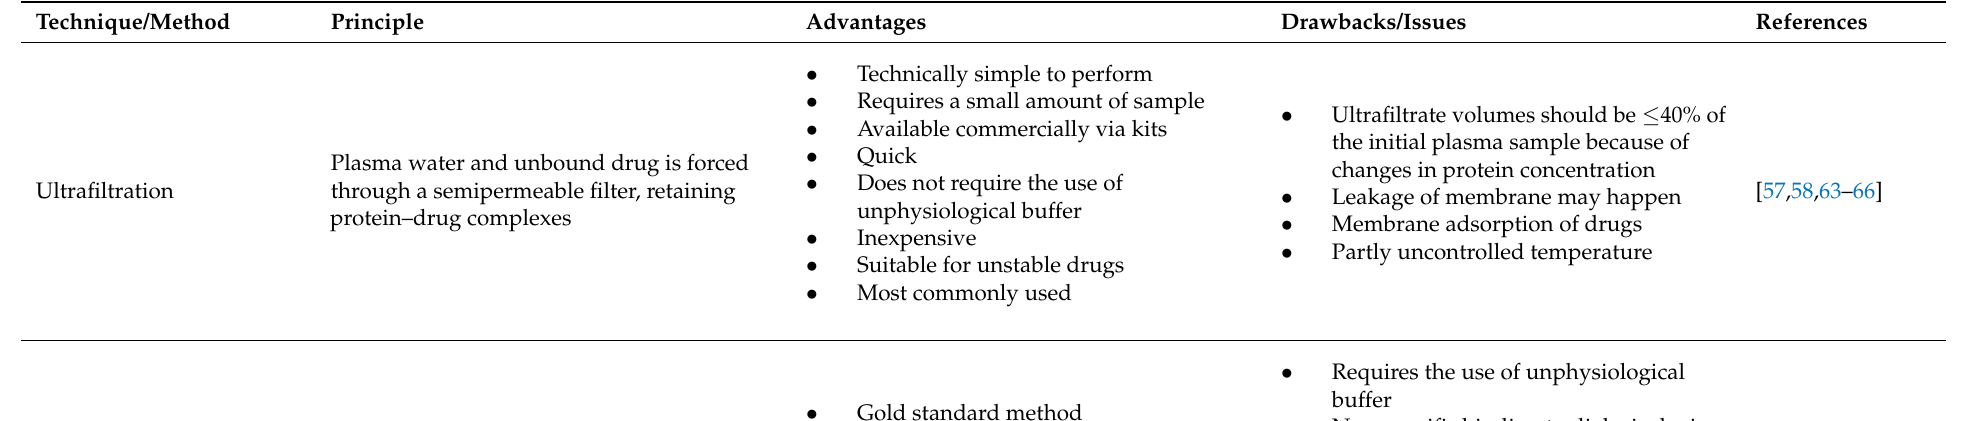
Table 2. Comparison of methods for plasma protein binding